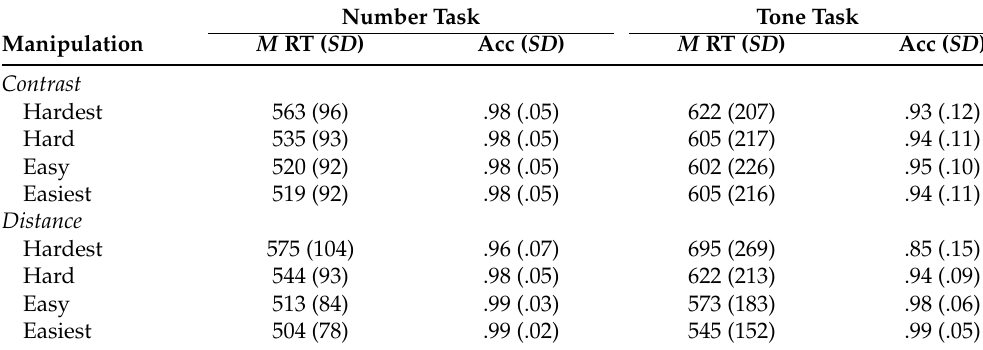
Table 7. Means and standard deviations (in parentheses) for reaction time (ms) and accuracy (propor- tion correct) across both manipulations’ levels of difficulty for number and tone comparison